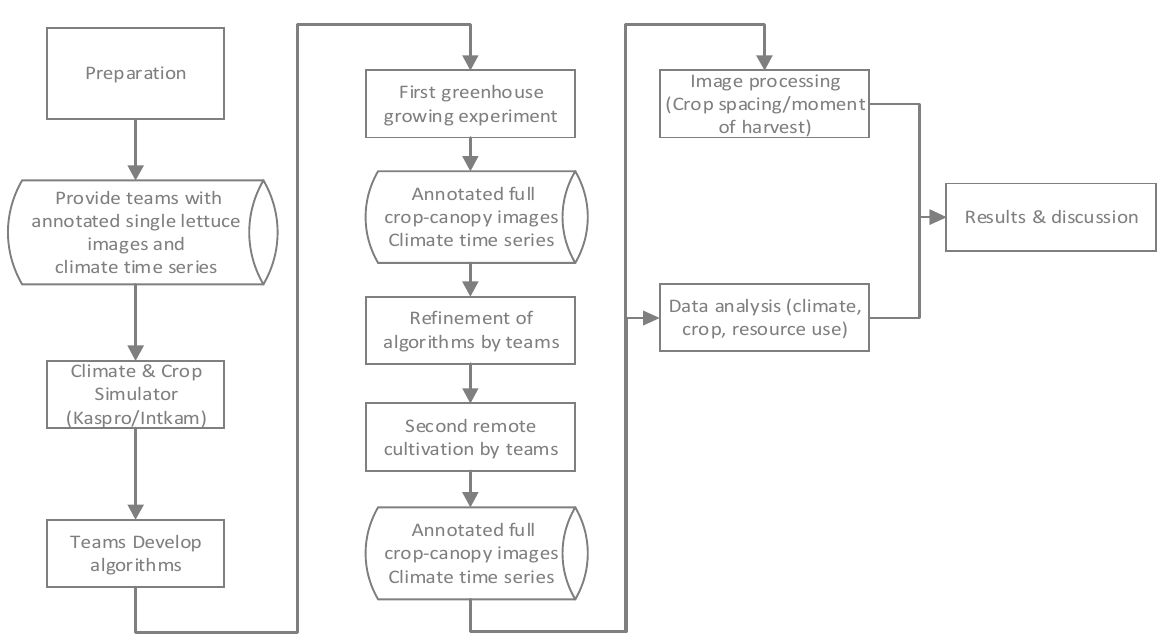
Figure 1. Research methodology of the growing experiments and analysis of results. Data from the annotated single lettuce images is found in [49], whereas the annotated full crop data are found in [56].